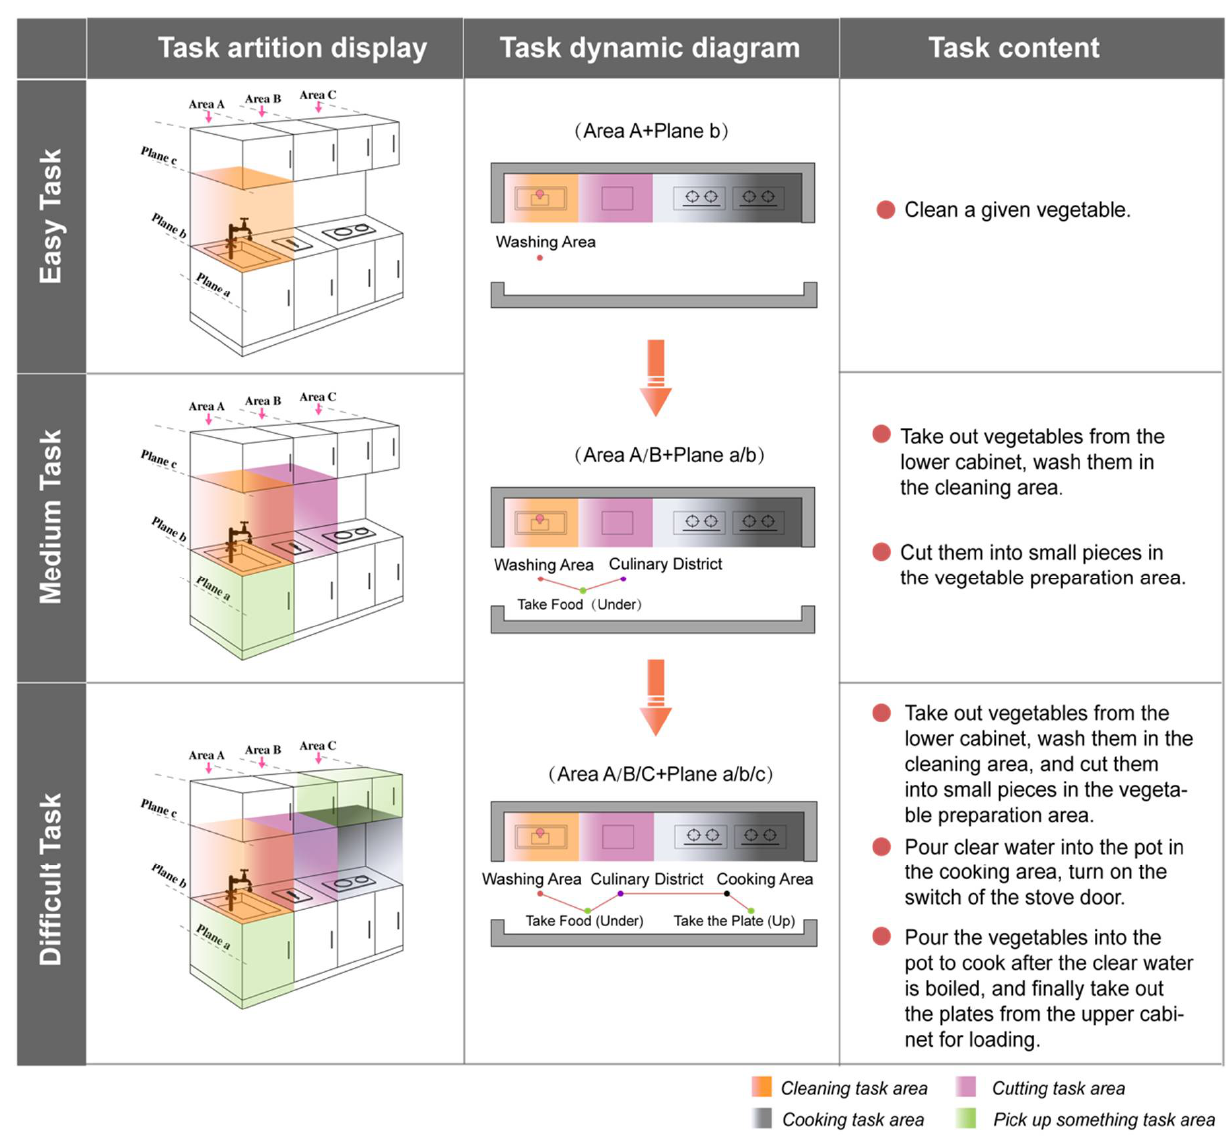
Figure 1. Different kitchen types’ zoning diagram. (1) I-shaped kitchen. (2) L-shaped kitchen. (3) U-shaped kitchen. Kitchen space façade partition is defined as (A) washing area, (B) preparation area, and (C) cooking area. Kitchen space plane partition height is defined as (a) yellow zone: bending posture storage space height of 50 cm; (b) red zone: normal standing posture, the ideal counter height of 90 cm; (c) blue zone: high cabinet storage space height of 180 cm or more.